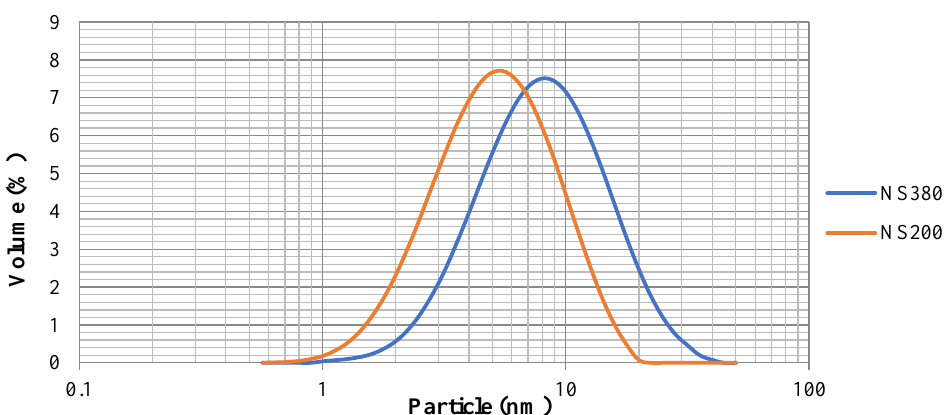
Fig. 2. Gradation of the nano particles used in this